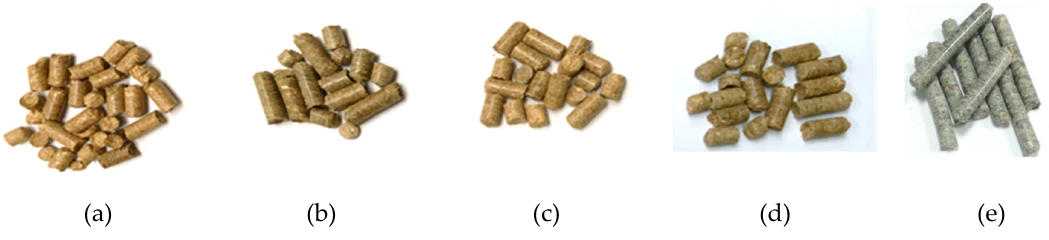
Figure 1. Produced samples: ( a ) S–100 ( b ) SPS–70/30 ( c ) SPS–80/20 ( d ) SPS–90/10 ( e ) PS–100.